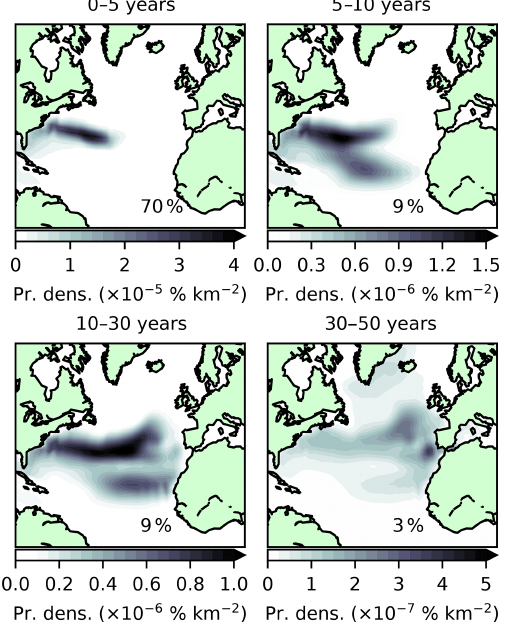
Figure 8. Surface origins of model NASMW as determined by the backtracking budget analysis (adjoint model simulation). Shading indicates probability density. This corresponds to the likelihood that model NASMW is formed in a given region during the time peri- ods [0,5], (5,10], (10,30], and (30,50] years. Inset percentages show the global integral (that is, the total proportion of the budget which is formed during each time period). Note that, contrary to Fig. 6, which displays instantaneous fields, here time-integrated fields are displayed. Due to the large variability in its extent over the integra- tion window, the outcrop region is not shown.